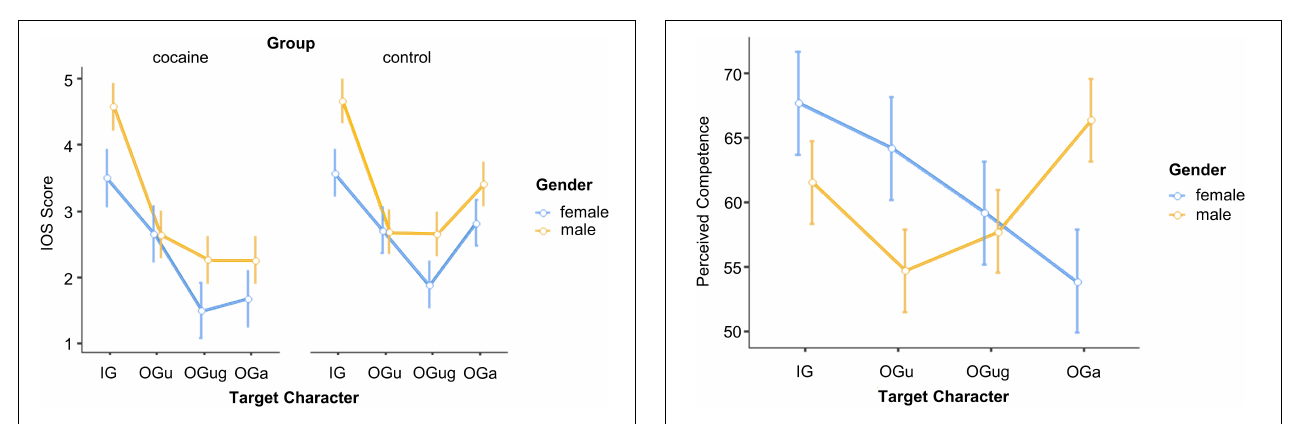
FIGURE 4 | Perceived competence of the different social targets. IG, in-group; OG u , out-group use; OG ug , out-group use + gender; OG a , out-group age. Error bars, standard